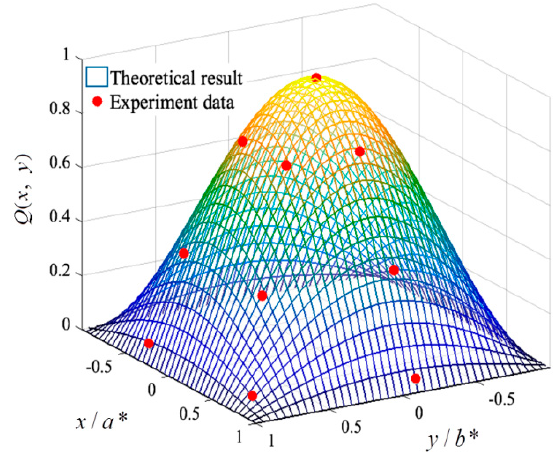
Figure 12. Validation of spatial distribution of impact load.